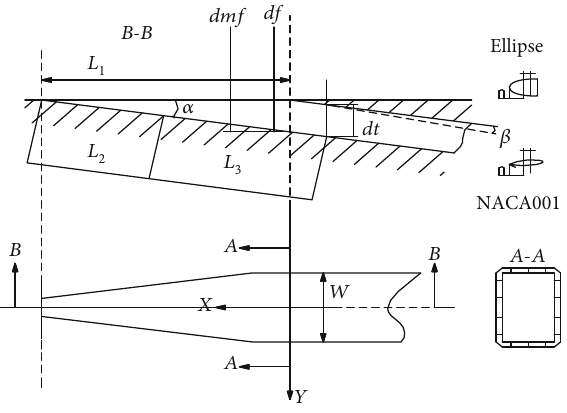
Figure 1: Diagram of a NACA ram air